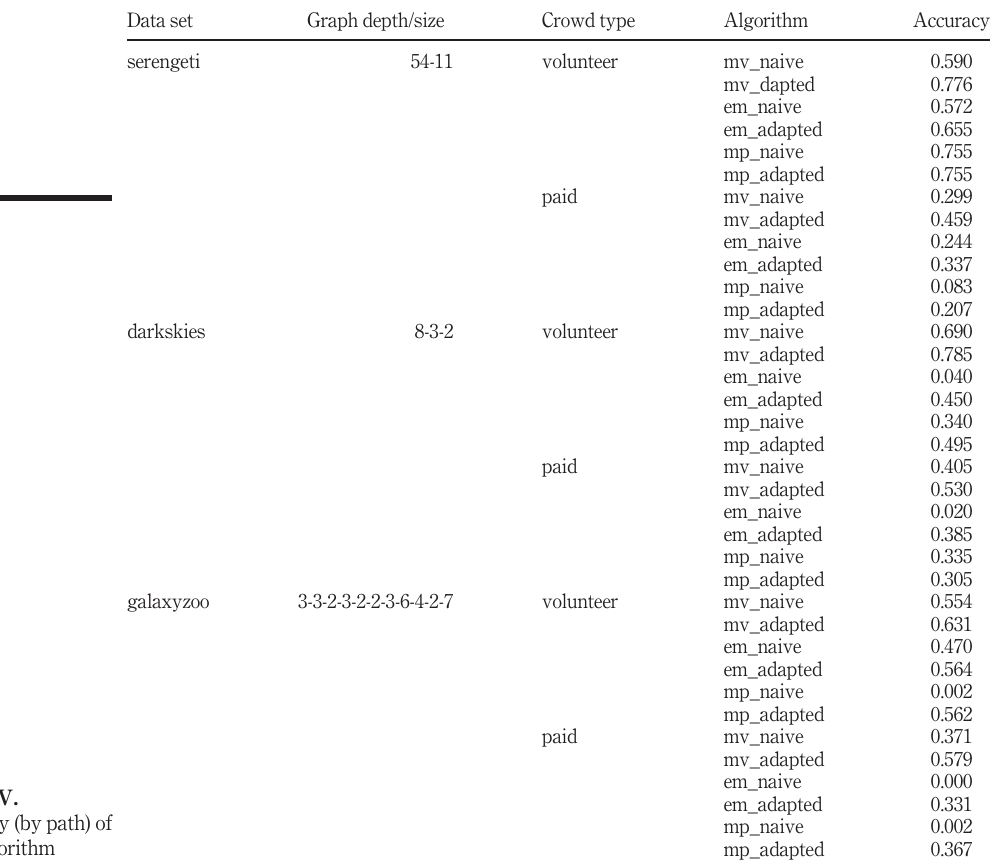
Table IV. Accuracy (by path) of each